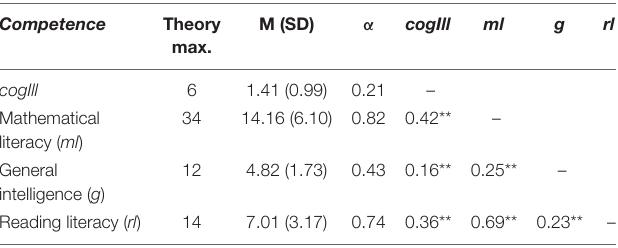
TABLE 2 | Descriptives (M, SD, α ) of and mutual (manifest) intercorrelations r (according to Spearman) between the constructs cogIll , ml , g , and